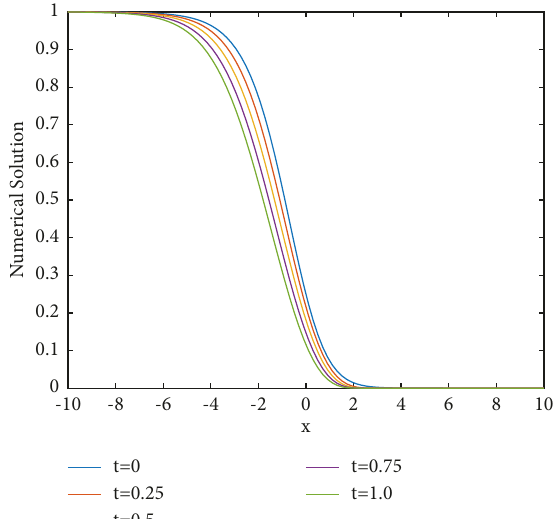
Figure 6: Wave profile of problem 2 at different time.